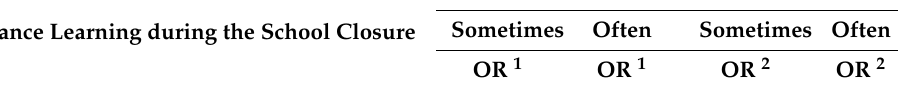
Table 5. Effects of distance learning variables on perceived loneliness. Results of multinomial logistic regression modelling. Odds ratios (OR) of bivariate and multivariate models. Significant variables in bold. Perceived Loneliness Sometimes Often Sometimes Often Distance Learning during the School Closure OR 1 OR 1 OR 2 OR